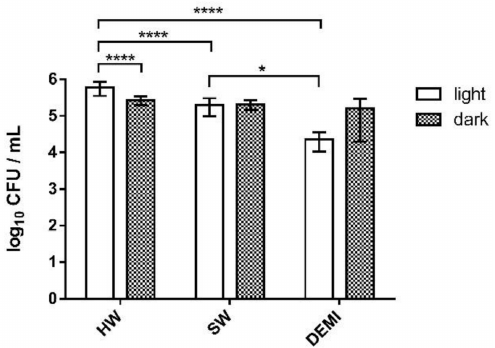
Figure 10. L. pneumophila biofilm formation in water samples of different hardness (HW, SW, and DEMI) with (=“light”) and without irradiation (=“dark”). For the samples that were illuminated, an LED-based source of violet light was used for 10 min treatment (395 nm, total light dose 12 J/cm 2 ). All data are presented as an average ± SD; **** p < 0.0001, * 0.01 < p <